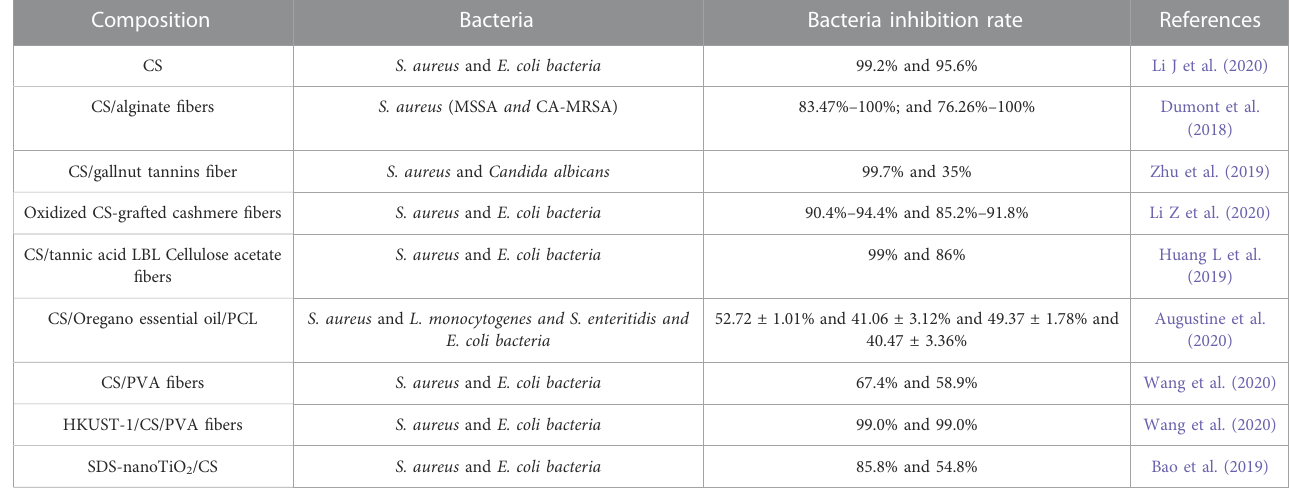
TABLE 1 Different bacteria reduction rates of CS-derived fi bers. Composition